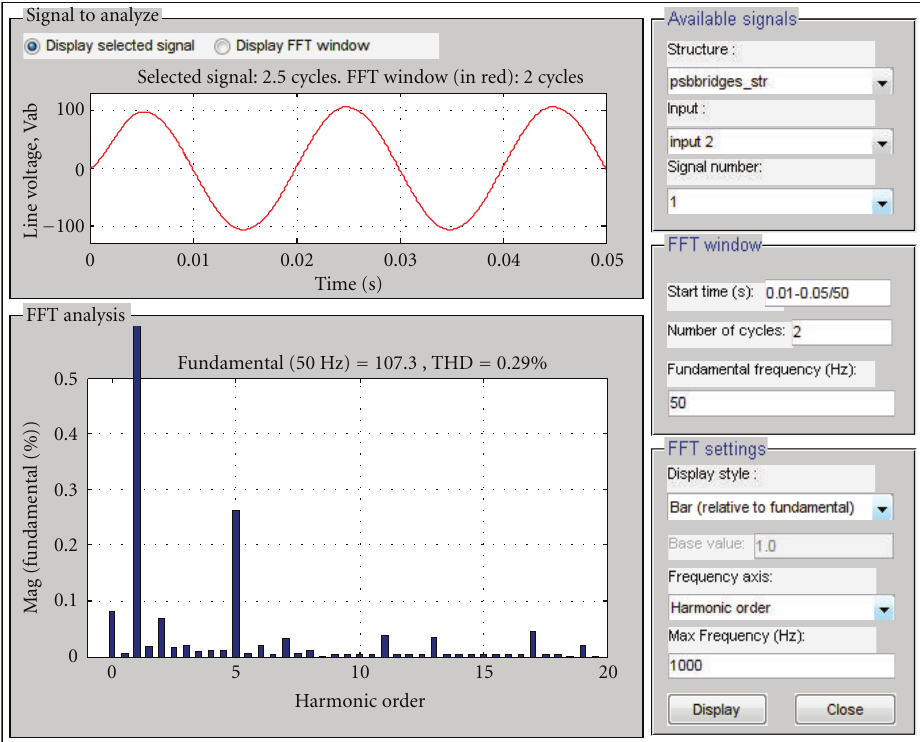
Figure 12: FFT analysis for simulation showing the THD and harmonic spectrum of the line voltage.